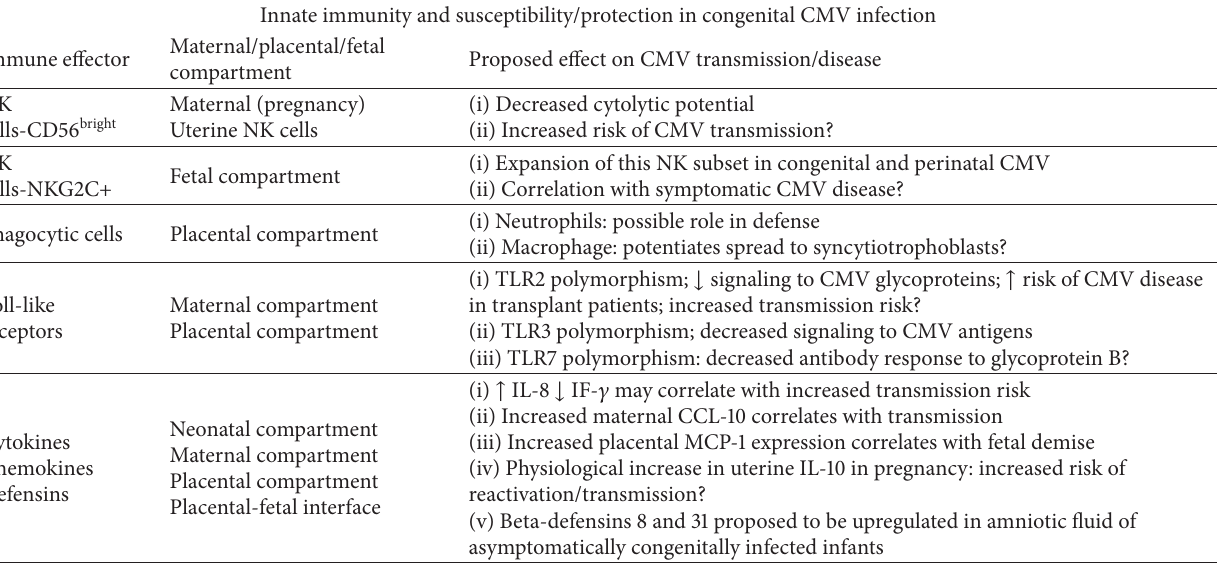
Table 1: Summary of innate immune responses and their proposed role in control of or susceptibility to congenital CMV infection. Innate immunity and susceptibility/protection in congenital CMV